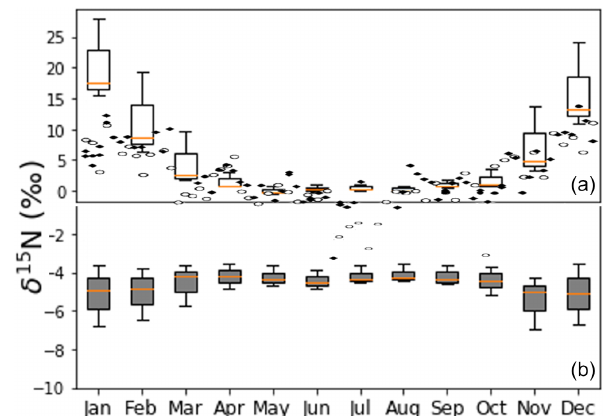
δ 15 N values of PM Figure 15. Panel (a) shows the observed NO − 3 in the city of Tucson (Riha, 2013) and box and whisker plots val- ues predicted by i N RACM (1-week simulation, red line: median, box: first and third quantile, whisker is minimum and maximum). Panel (b) shows whisker plots for i N RACM simulations with Reac- tion (R39) 15 α = 0 . 9971 from Freyer